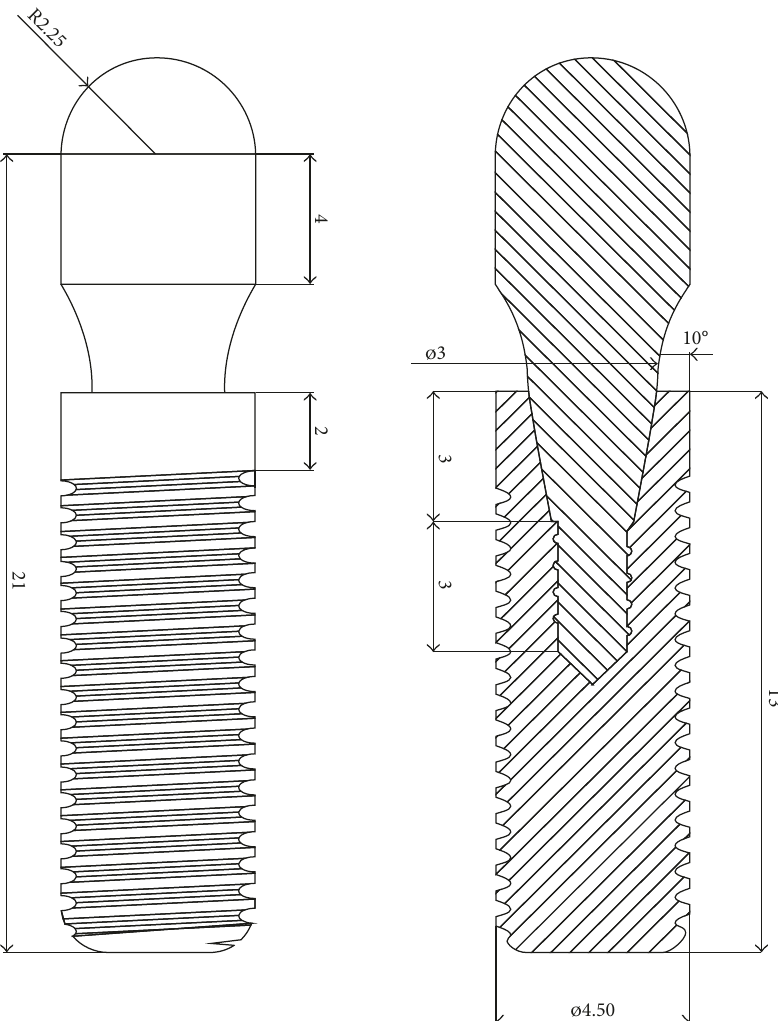
Figure 1: Side and sectional views and main dimensions of the implant and abutment